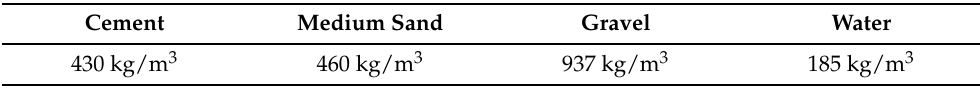
Table 2. The amount of ingredients in the